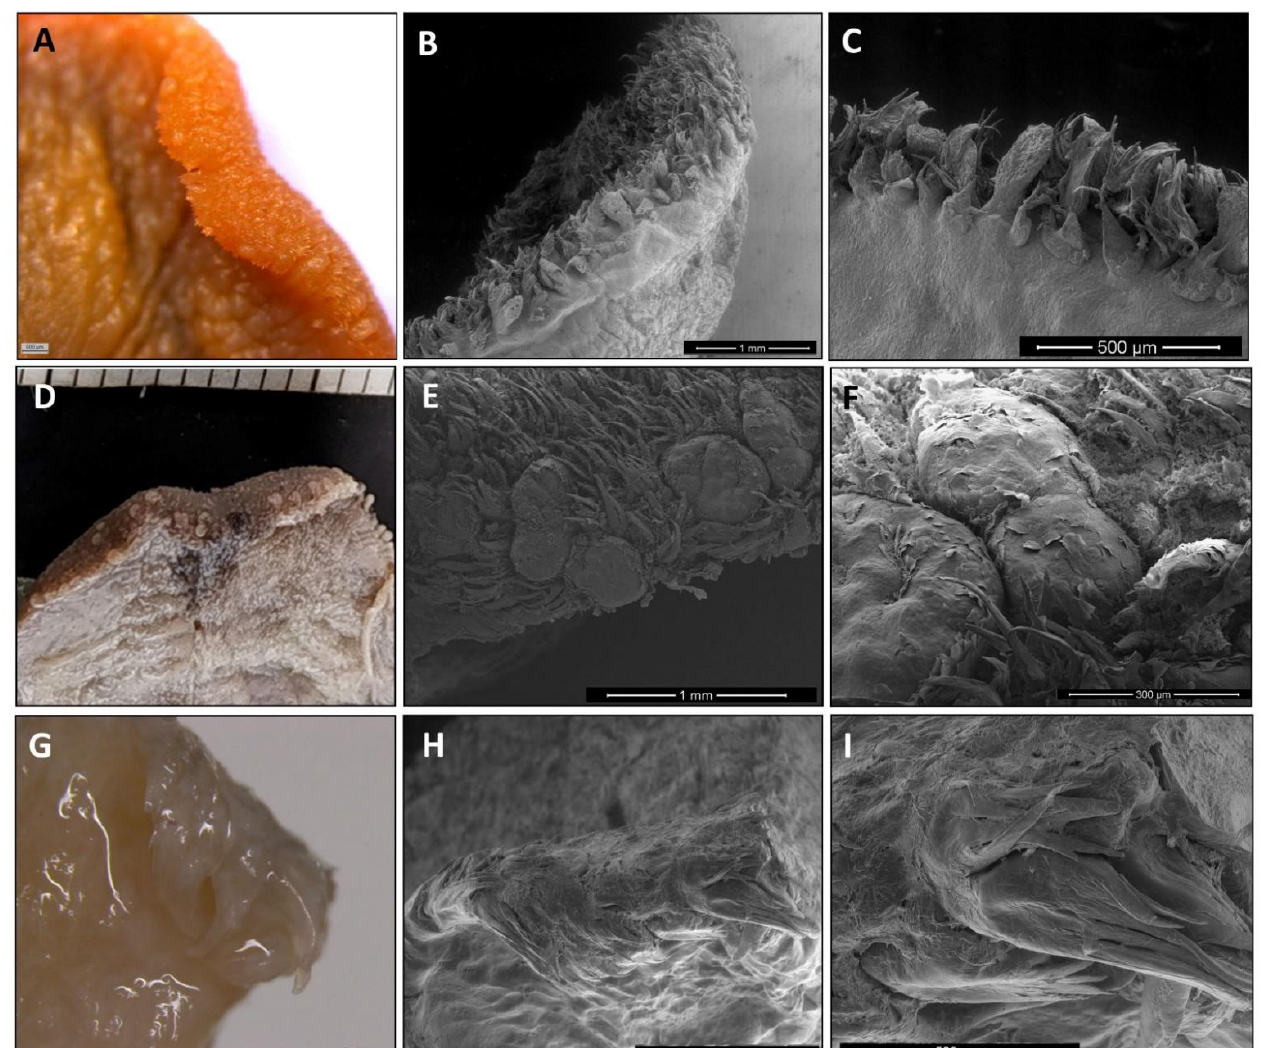
Figure 3. Images from Lemur catta ( A – C ), Varecia variegata ( D – F ) and Eulemur macaco ( G – I ) tongue’s tip. In all images the ventral surface is observed in the inferior part of the picture. The tip in the flower-feeding species present bigger and modified papillae ( Varecia variegata ) or is like a brush with long filiform-like papillae. In Lemur catta there are no differences in papillae morphology or distribution when compared with the rest of the tongue’s edge. In image ( D ), the minor division of the scale corresponds to one millimeter.